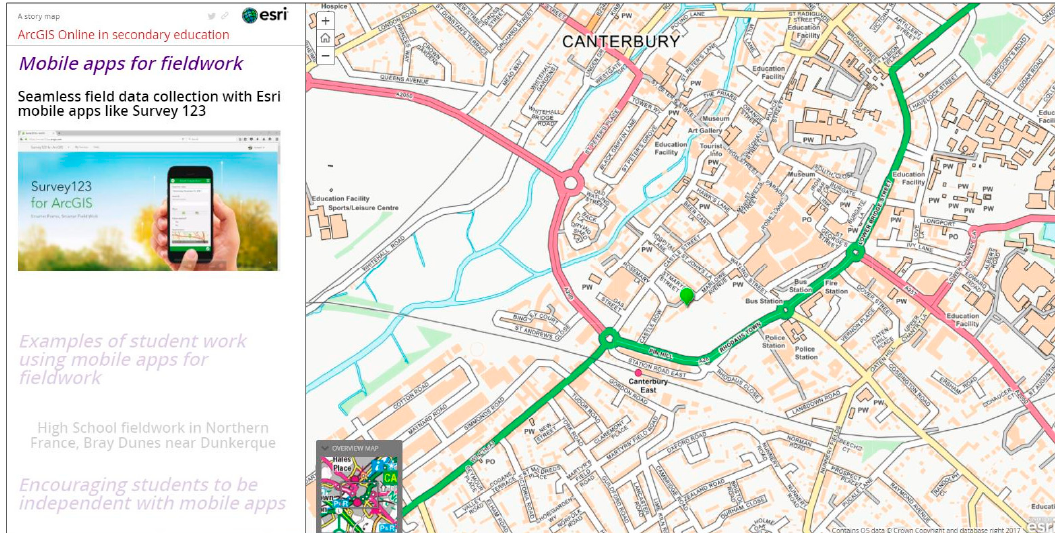
Figure 3. Fieldwork data collection with ESRI ArcGIS Online and Survey 123.